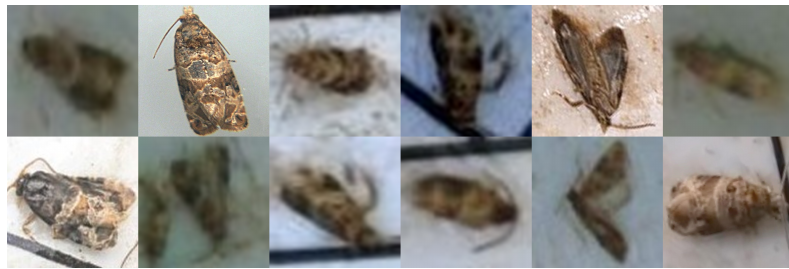
Figure 7. Grapevine moth males images that resulted from the annotation process. Table 3. Grapevine moth males augmented dataset